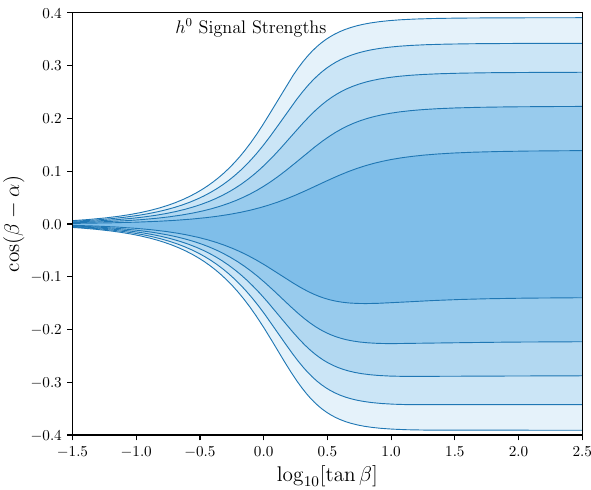
Figure 1 . Combined fits of the SM Higgs signal strengths in the 2HDM-I (in the ( tan β − cos( β − α ) ) plane). Contours are shown representing allowed parameter space at 1, 2, 3, 4, 5 σ confidence from darkest to